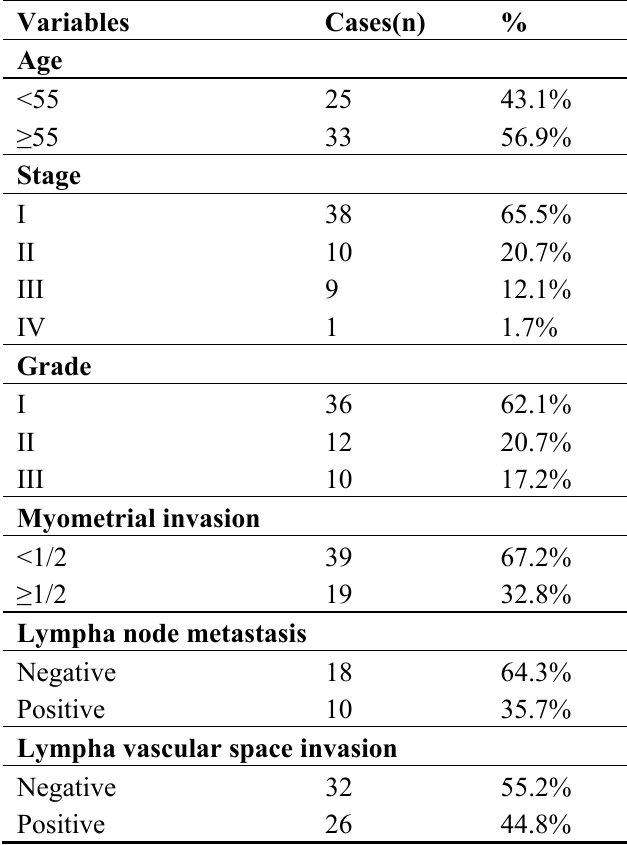
Table 1. Summarization of patients’ clinico-pathological